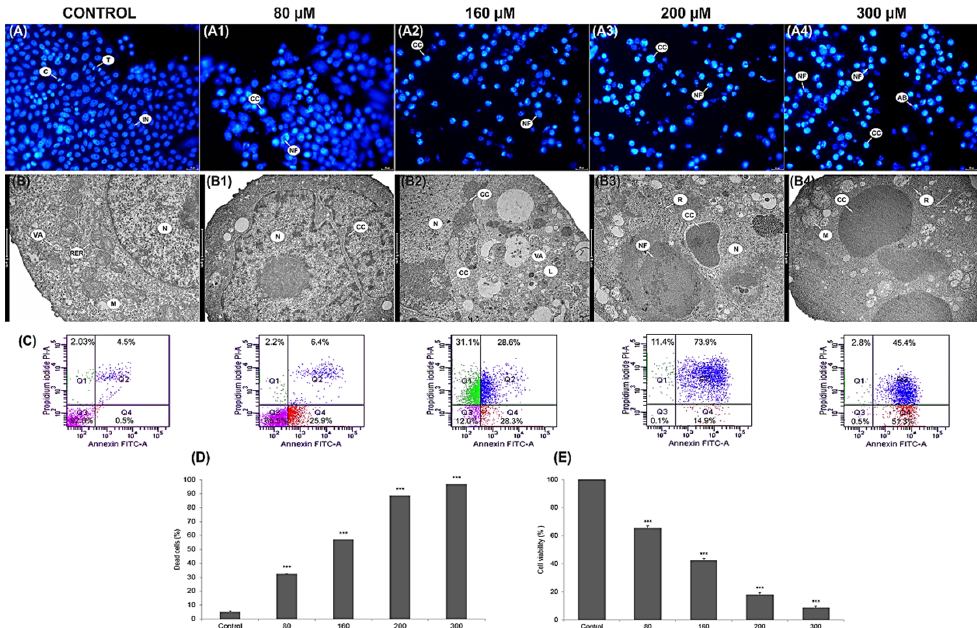
Figure 1. Physcion-induced apoptotic death of HeLa cells. Apoptosis observed in HeLa cells after physcion